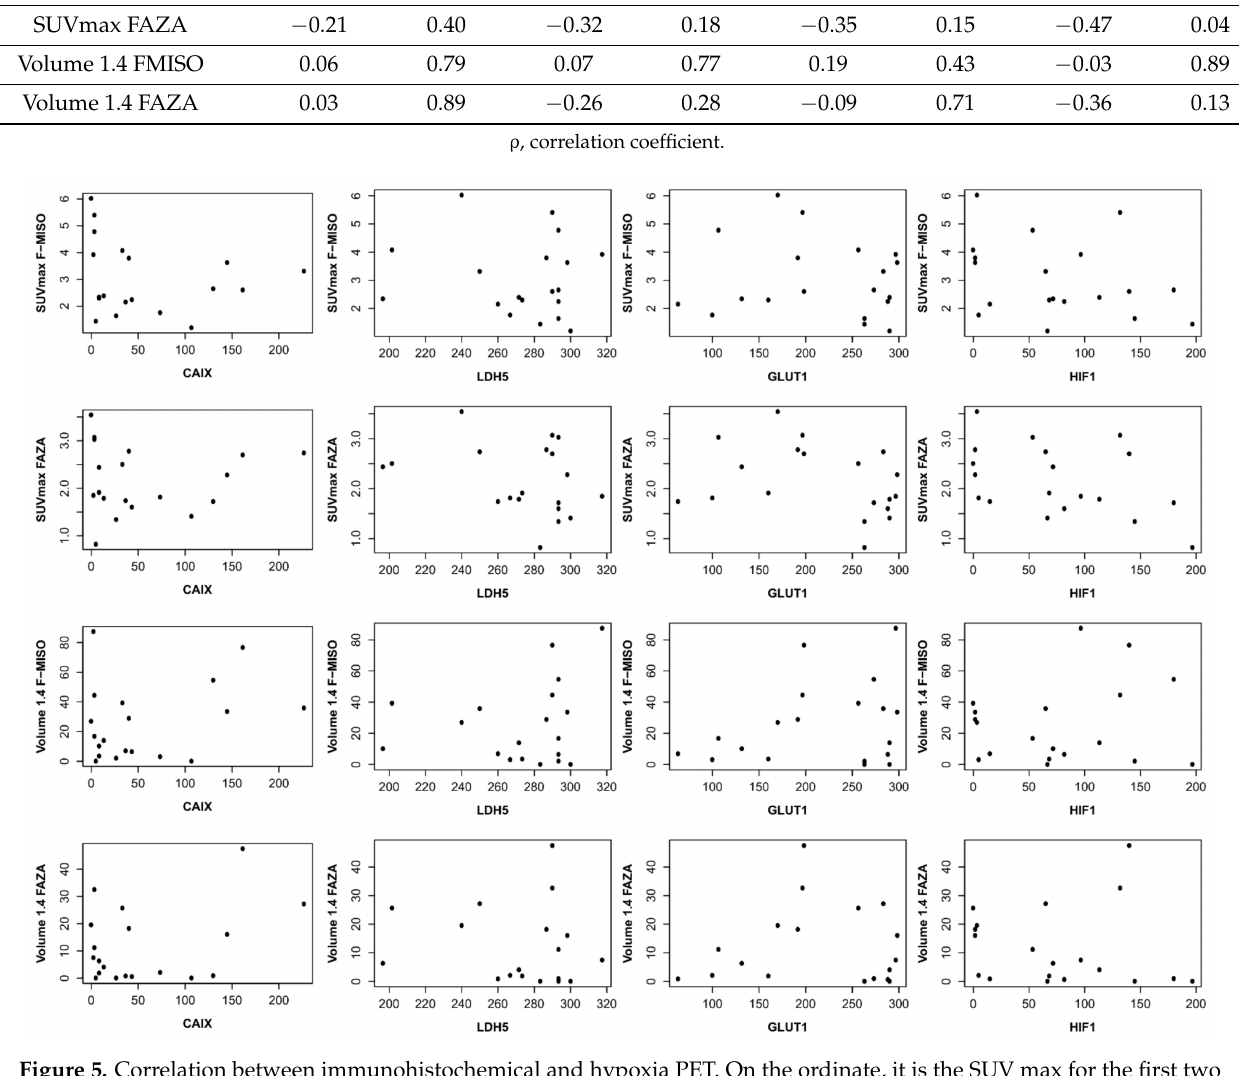
Figure 5. Correlation between immunohistochemical and hypoxia PET. On the ordinate, it is the SUV max for the first two lines and the volume in cc for the last two lines. On the abscissa, the immunohistochemistry score (score described by Allred et al.